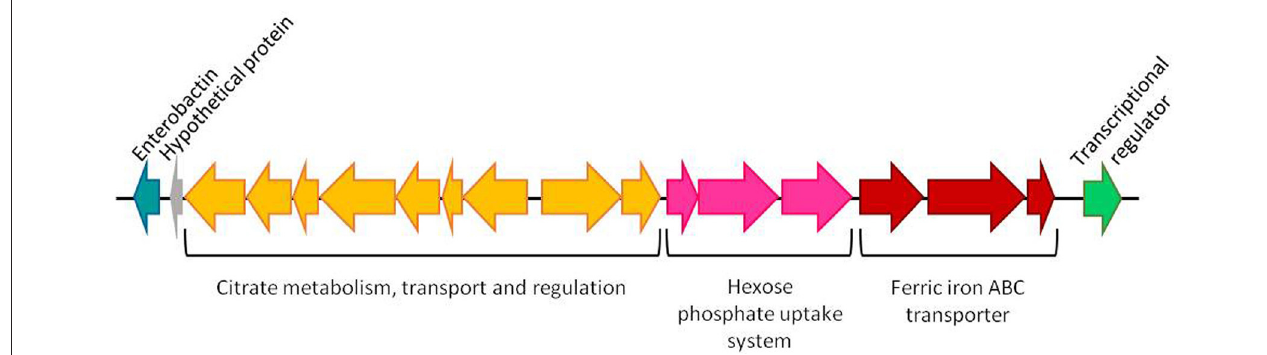
FIGURE 3 | Cluster of genes absent from Y. ruckeri ATCC29473 type strain and present in the strains Y. ruckeri 150, CSF007-82, Big Creek and SC09. The region contains genes encoding for an enterobactin-like siderophore (blue), nine genes involved in the uptake and metabolism of citrate (yellow), a group of three genes related to hexose phosphate uptake (pink), three genes involved in iron transport (red) and a Crp-Fnr family transcriptional regulator (green). (1) Citrate succinate antiporter, (2) 2-(5 ′ -triphosphoribosyl)-3 ′ -dephosphocoenzyme-A synthase, (3) Apo-citrate lyase phosphoribosyldephospho-CoA transferase, (4) Citrate lyase alpha chain, (5) Citrate lyase beta chain, (6) Citrate lyase gamma chain acyl carrier protein, (7) [Citrate[pro-3S]-lyase] ligase, (8) Sensor kinase, (9) Transcriptional regulatory protein, (10) Transcriptional regulatory protein, (11) Sensor histidine protein kinase glucose-6-phosphate specific, (12) Hexose phosphate uptake regulatory protein, (13) Ferric iron ABC transporter iron-binding protein, (14) Ferric iron ABC transporter permease protein, (15) Ferric iron ABC transporter binding subunit (Figure taken from Cascales et al., 2017).